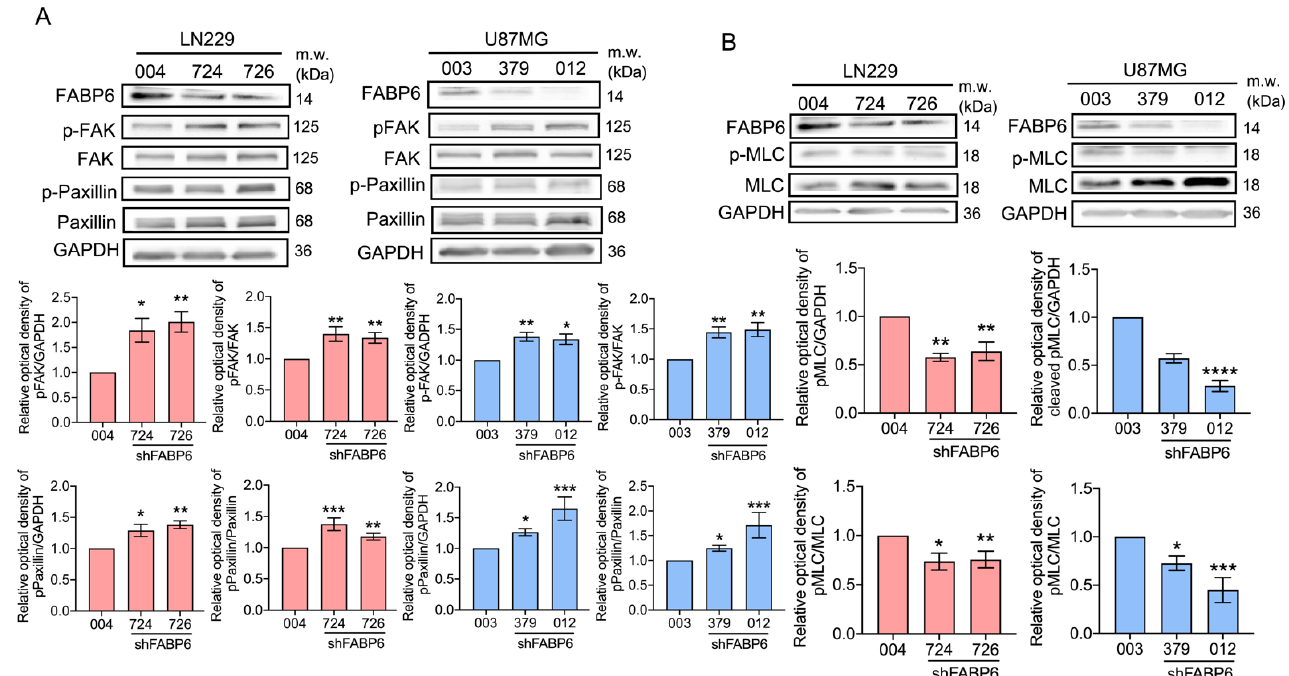
Figure 3. Effects of shFABP6 on the expression levels of the focal adhesion-related proteins in glioma cells: ( A ) focal adhesion kinase (FAK), phospho-focal adhesion kinase (p-FAK), paxillin, and phospho-paxillin (p-paxillin); ( B ) myosin light chain (MLC) and phospho-myosin light chain (p-MLC) were analyzed by Western blotting in the LN229 and U87MG cells using the shScramble control group (004 in LN229 cells and 003 in U87MG cells) and shFABP6. Glyceraldehyde-3-phosphate dehydrogenase (GAPDH) was used as the endogenous control. The plotted graphs show the relative quantitative analysis of the aforementioned proteins. * p < 0.05; ** p < 0.01; *** p < 0.001; **** p < 0.0001 compared with the shScramble control